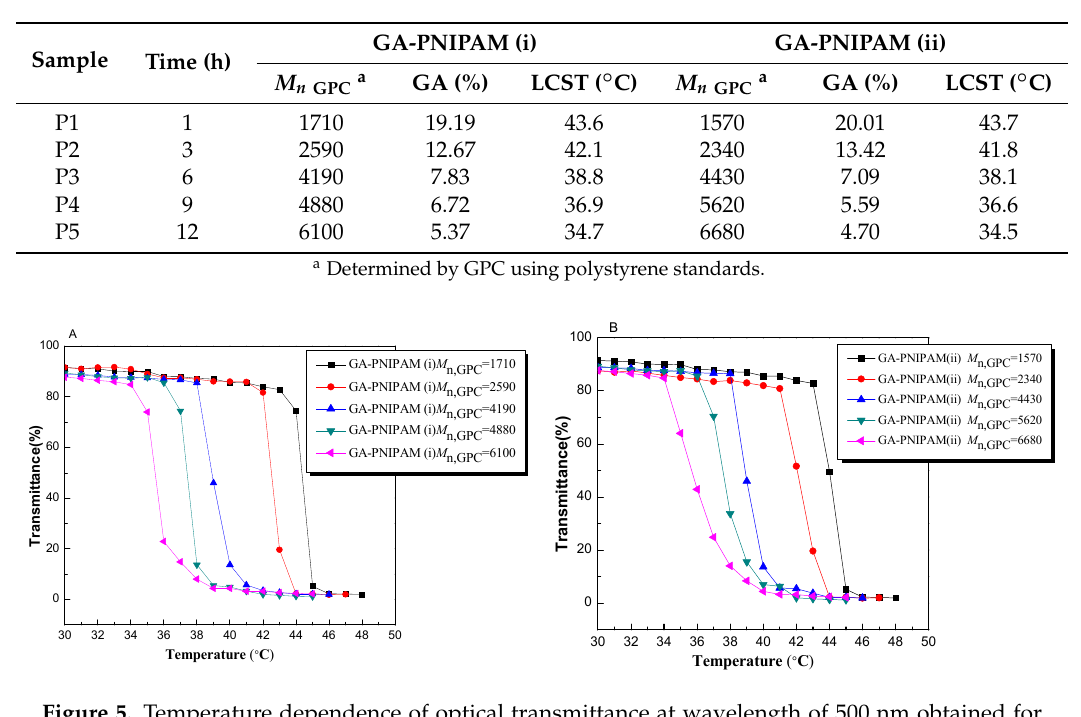
Table 2. Characteristics of GA-PNIPAM (i) and (ii).